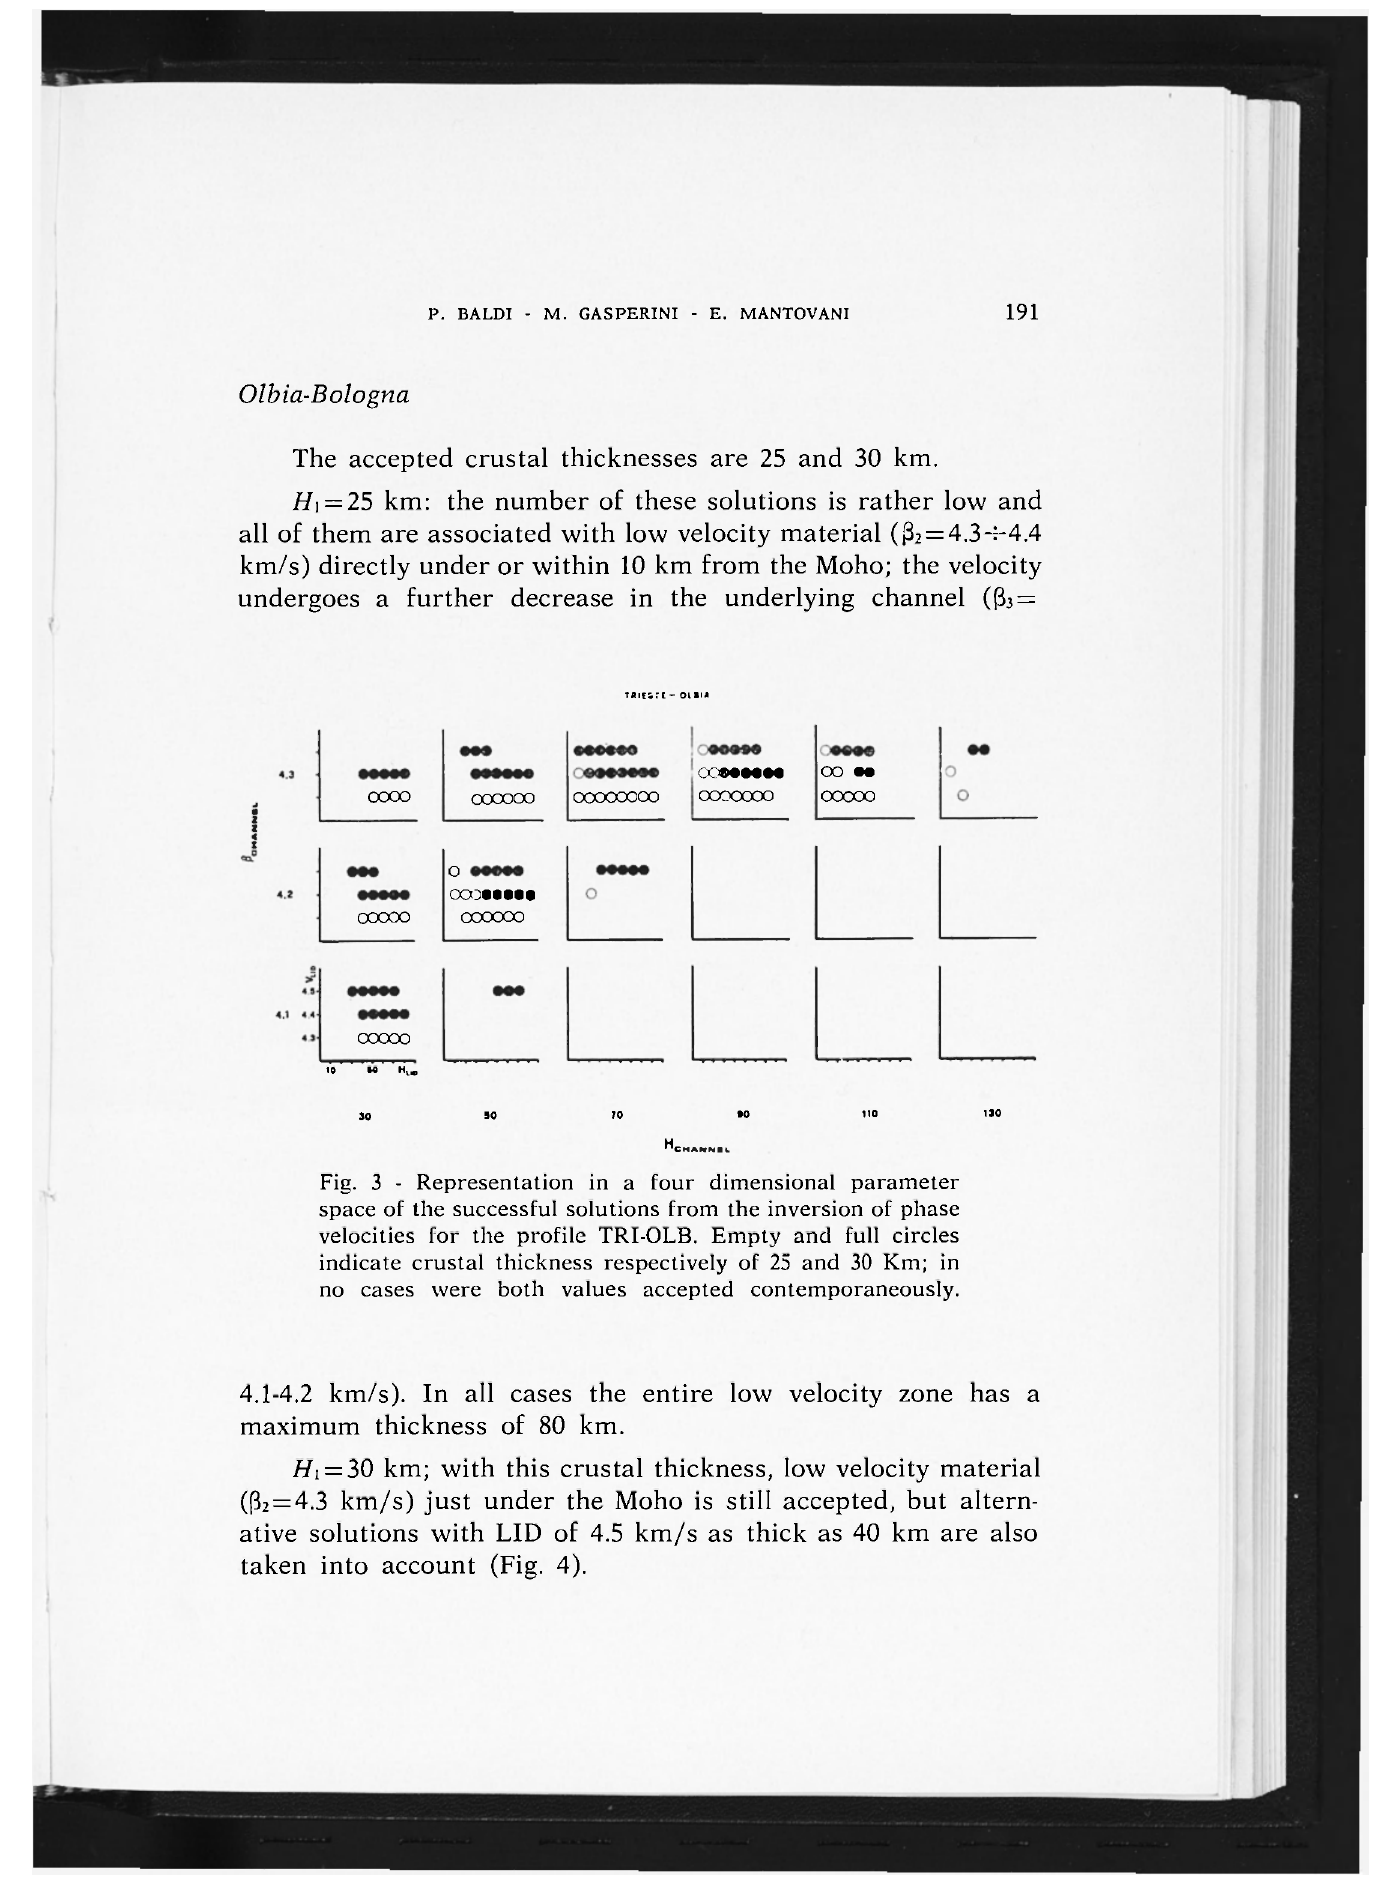
Fig. 3 - Representation in a four dimensional parameter space of the successful solutions from the inversion of phase velocities for the profile TRI-OLB. Empty and full circles indicate crustal thickness respectively of 25 and 30 Km; in no cases were both values accepted